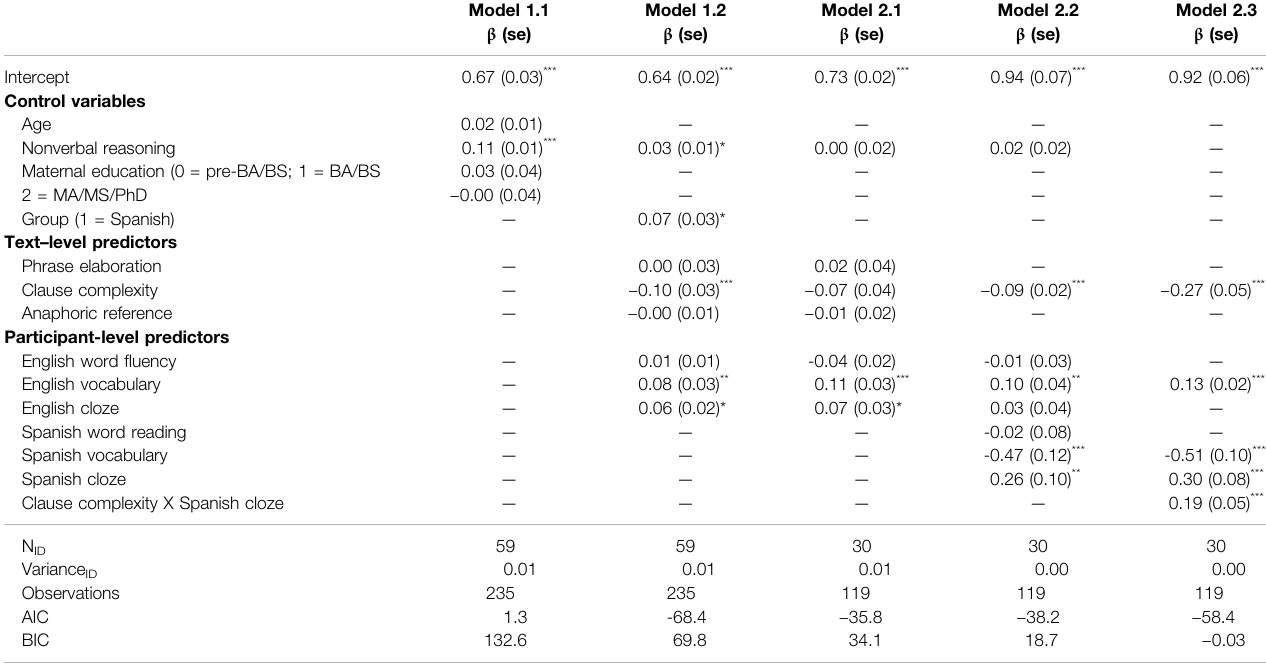
TABLE 6 | Results of fi tting a taxonomy of multi-level gaussian regression models for English paragraph comprehension scores as a function of control variables age, nonverbal reasoning and maternal education, and predictor variables English word fl uency, English vocabulary, English cloze, Spanish vocabulary, and Spanish cloze accuracy, n (cid:1) 59 middle-schoolers, displaying standardized coef fi